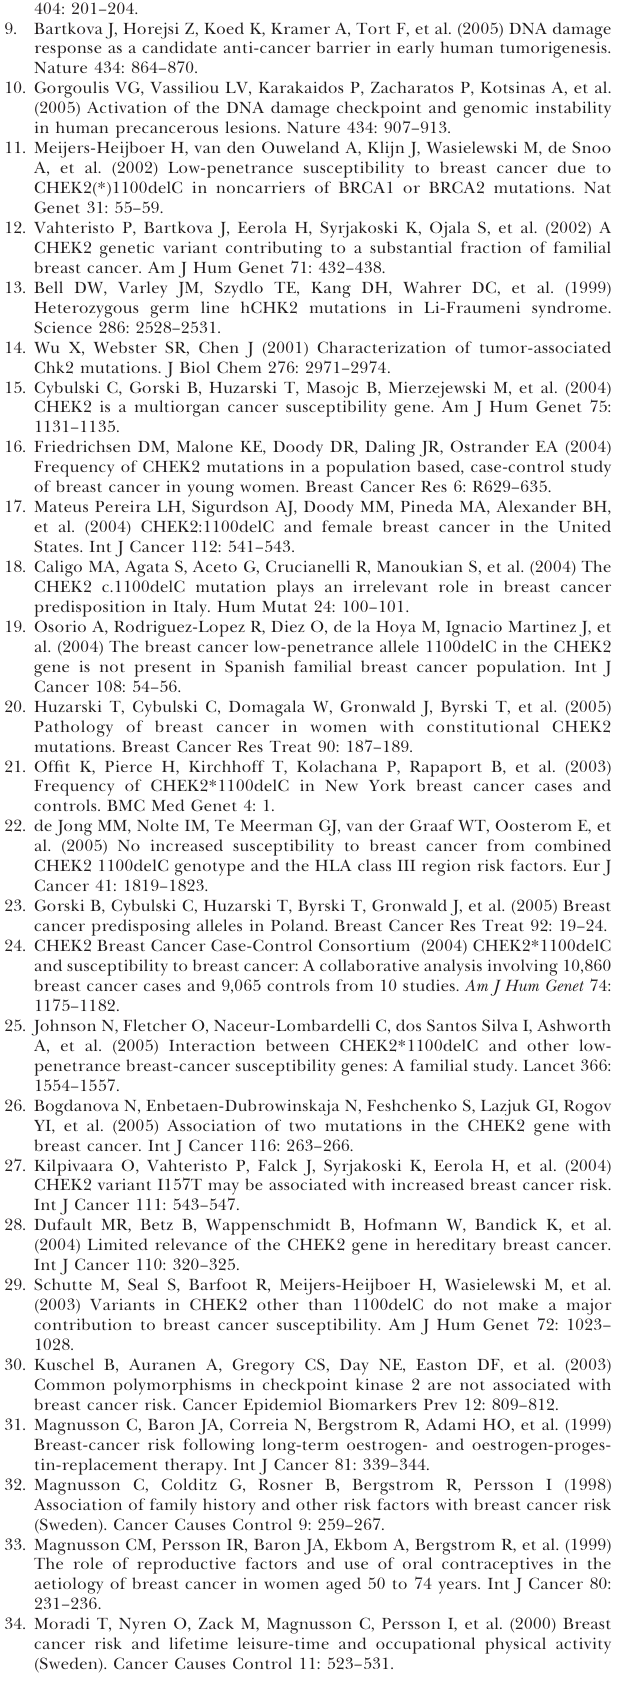
Table S3. Common Haplotypes Reconstructed Using Six tagSNPs in CHEK2 in Relation to Breast Cancer Risk, by Family History Family history was considered positive for participants who had at least one first-degree relative with breast cancer. Table S4. Common Haplotypes Reconstructed Using Six tagSNPs in CHEK2 in Relation to Breast Cancer Risk, Stratified by Body Mass IndexBody mass index is calculated as weight/height 2 (kg/m 2 ). Table S5. Common Haplotypes Reconstructed Using Six tagSNPs in CHEK2 in Relation to Breast Cancer Risk, Stratified by Age at First Childbirth Found at DOI: 10.1371/journal.pmed.0030168.st005 (51 KB DOC). Table S6. Common Haplotypes Reconstructed Using Six tagSNPs in CHEK2 in Relation to Breast Cancer Risk, Stratified by Duration of Use of Any Kind of Medium-Potency Oestrogens Found at DOI: 10.1371/journal.pmed.0030168.st006 (51 KB DOC). Table S7. Common Haplotypes Reconstructed Using Six tagSNPs in CHEK2 in Relation to Breast Cancer Risk, Stratified by Parity Found at DOI: 10.1371/journal.pmed.0030168.st007 (55 KB DOC). Table S8. Association between Six tagSNPs in CHEK2 and Breast Cancer Risk Found at DOI: 10.1371/journal.pmed.0030168.st008 (47 KB